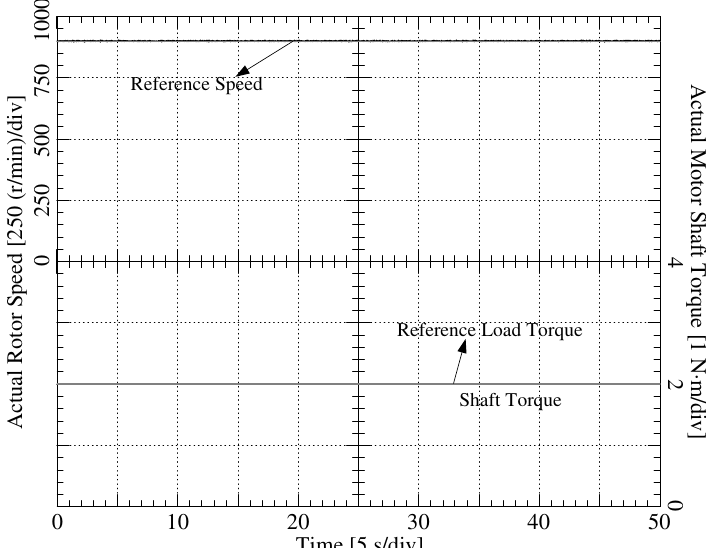
Figure 12. Experimental steady-state nominal speed (900 r/min) response under full load (2 N·m) with K = 5 (high) while R s is increased by 82.35% and λ f is decreased by